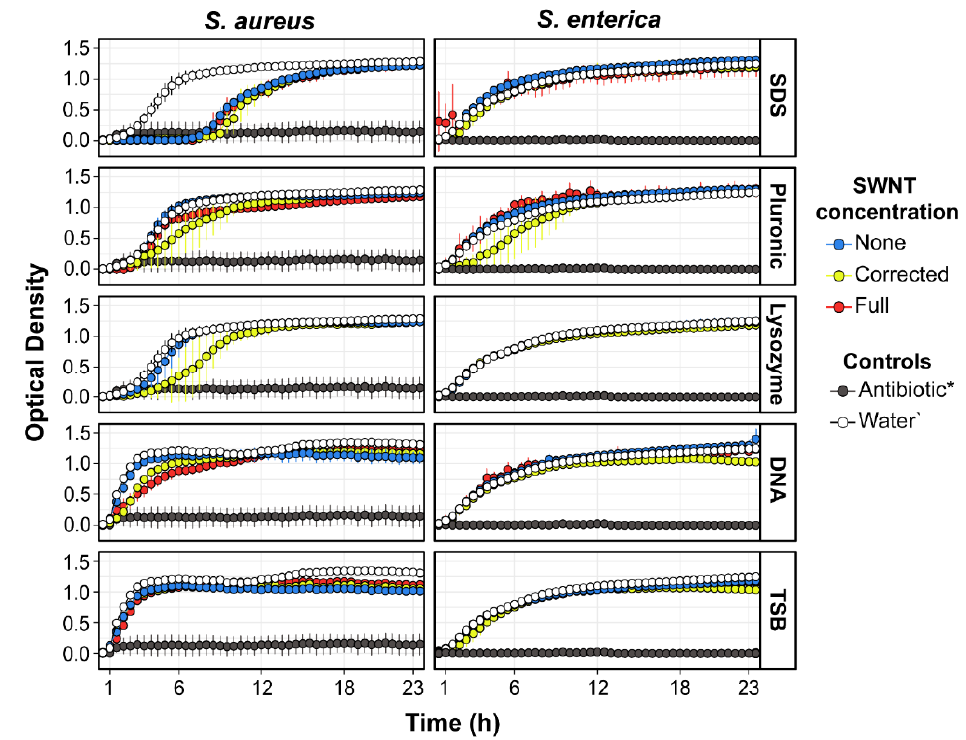
Figure 4. Growth curves of inoculums of Staph. aureus and Salmonella after challenge with the 17 treatments TSB medium. Growth measured as optical density at 600 nm wavelength every 30 min for 24 h. Longer lag phases indicate that cells were sustaining damage and/or under increased stress. None: no SWNTs; Corrected: SWNT concentration corrected to 0.227 mg/mL for comparison across all dispersants; Full: full-strength SWNT concentrations as shown in Table 2. Antibiotic*: Chloramphenicol for Salmonella and vancomycin for Staph. aureus.